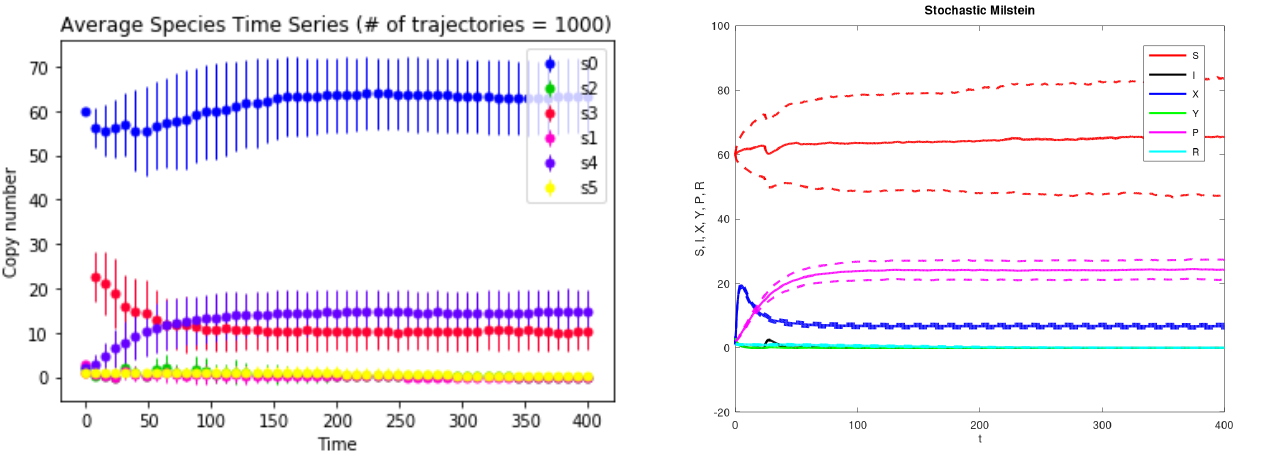
Figure 9. Plots for mean values and the mean values +/ − 1 standard deviation for the virus plant model with saturation and delays. ( Left ) SSA with the vertical lines giving the intervals (mean − 1 standard deviation, mean + 1 standard deviation). ( Right ) Stochastic differential equations with the solid lines giving the mean values and the dashed lines the means +/ − 1 standard